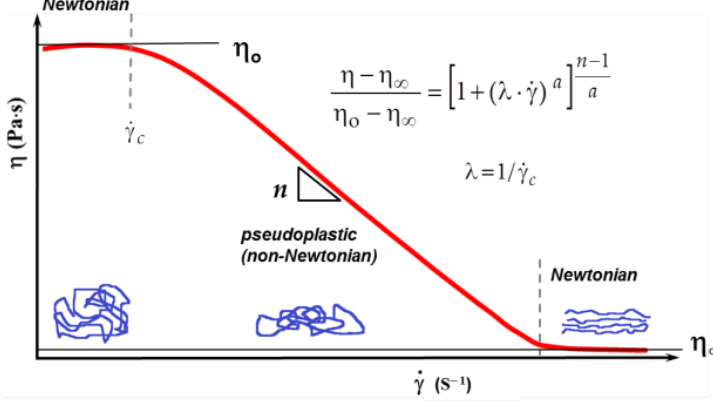
Figure 2. A complete viscosity curve as a function of shear rate, described by the Carreau– Yasuda model.